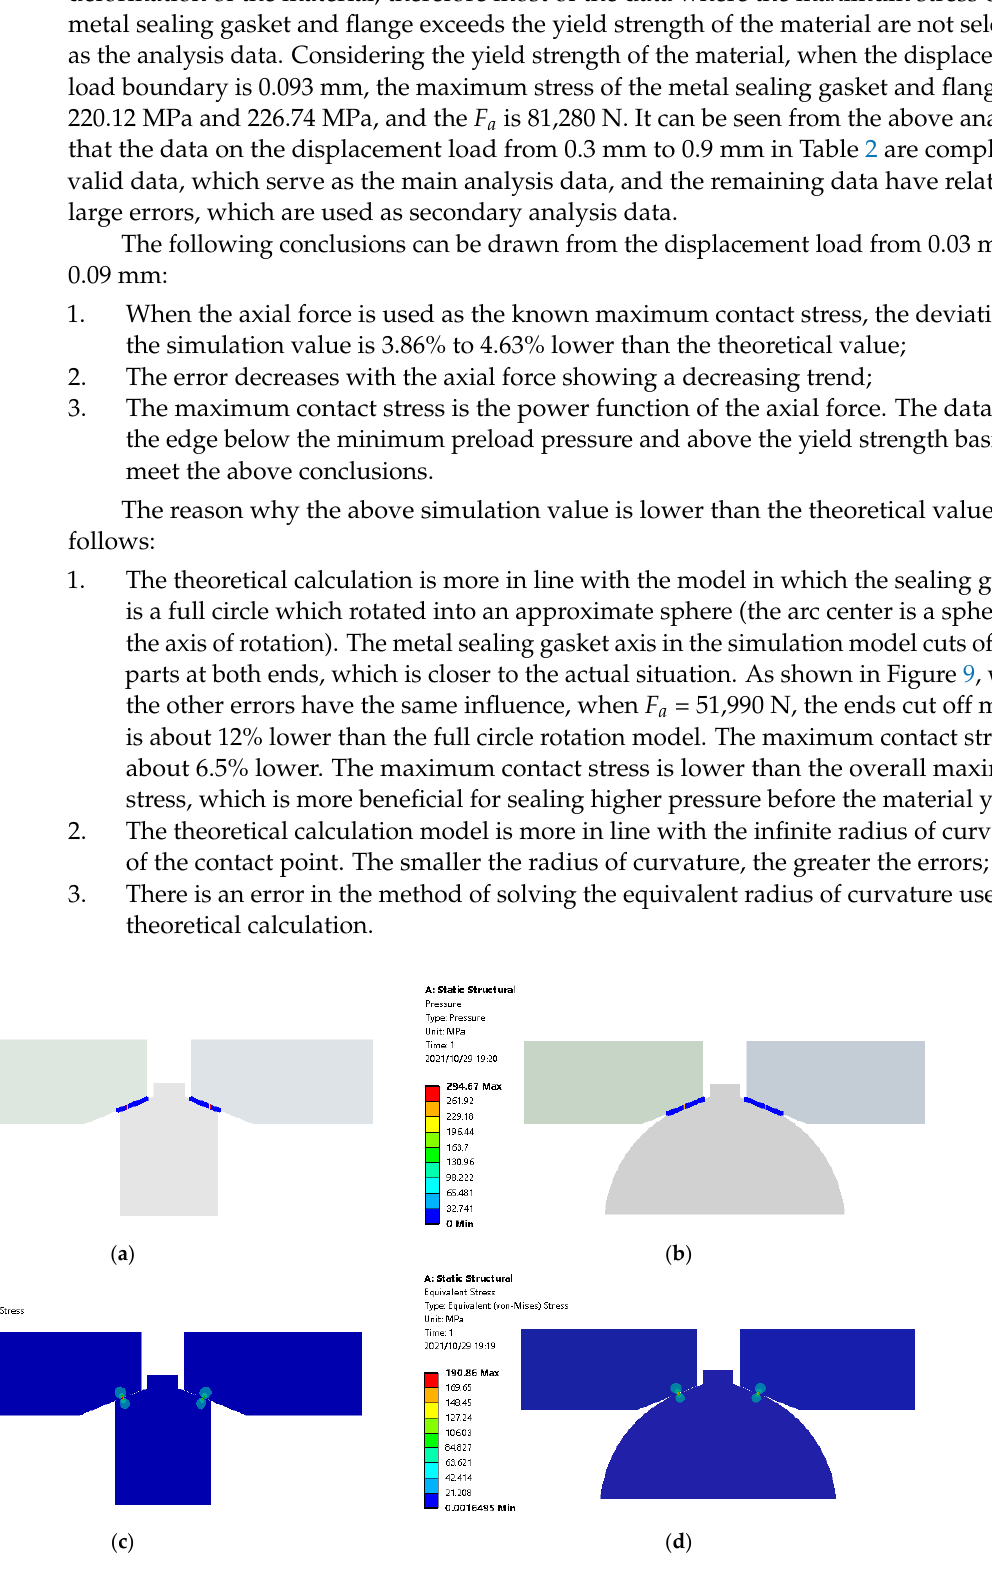
Figure 9. Contact stress and equivalent stress. ( a ) Contact stress of ends cut off model; ( b ) contact stress of full circle rotation model; ( c ) equivalent stress of ends cut off model; ( d ) equivalent stress of full circle rotation model.